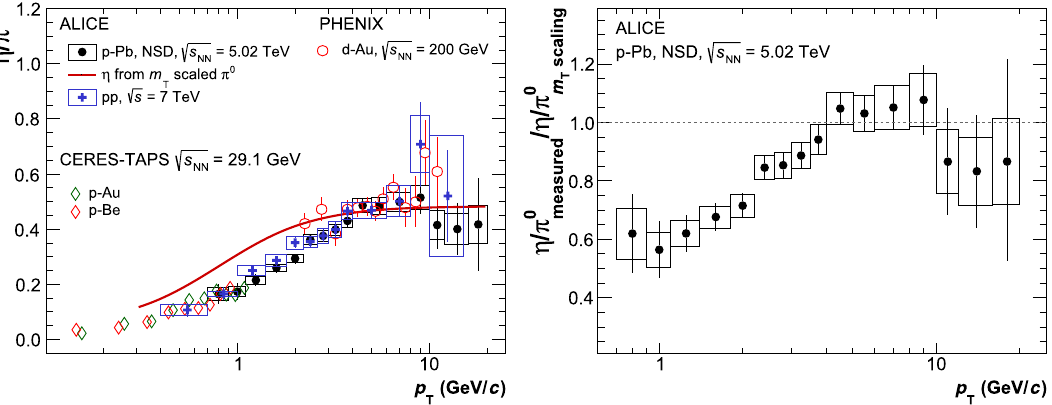
√ s at √ NN = 200 GeV with PHENIX [30], and in p–Au and p–Be colli- s sions at NN = 29.1 GeV with TAPS/CERES [36] are shown, as well as the ratio where the η yield is obtained via m T scaling from the mea- sured p–Pb π 0 yield. Right: Ratio of the measured η / π 0 ratio to the one obtained via m T